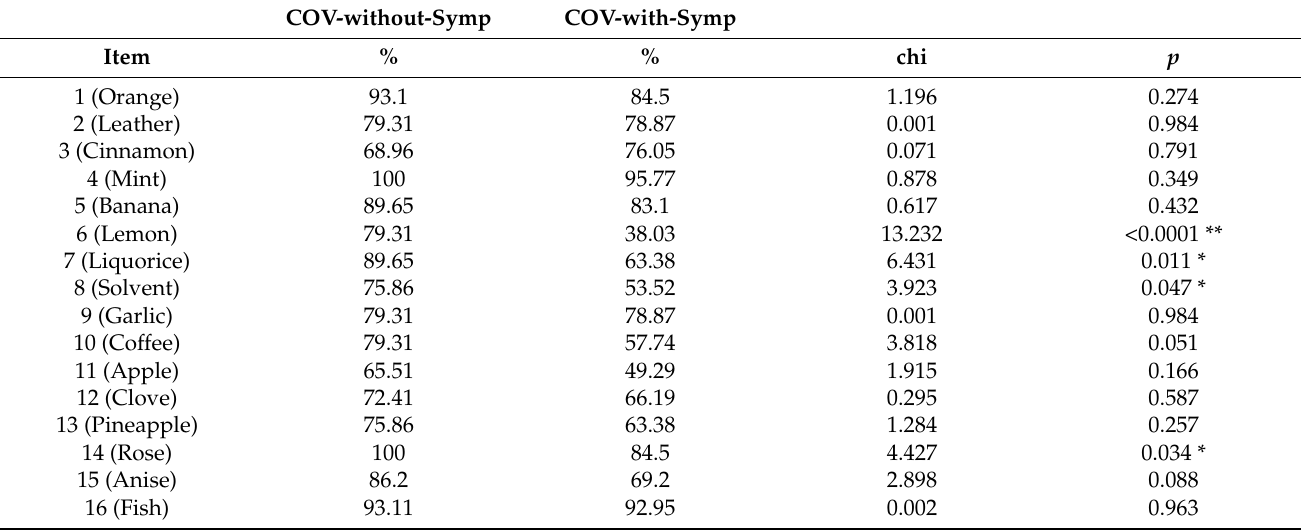
Table 4. Percentage of success per item in Identification–Recognition score.